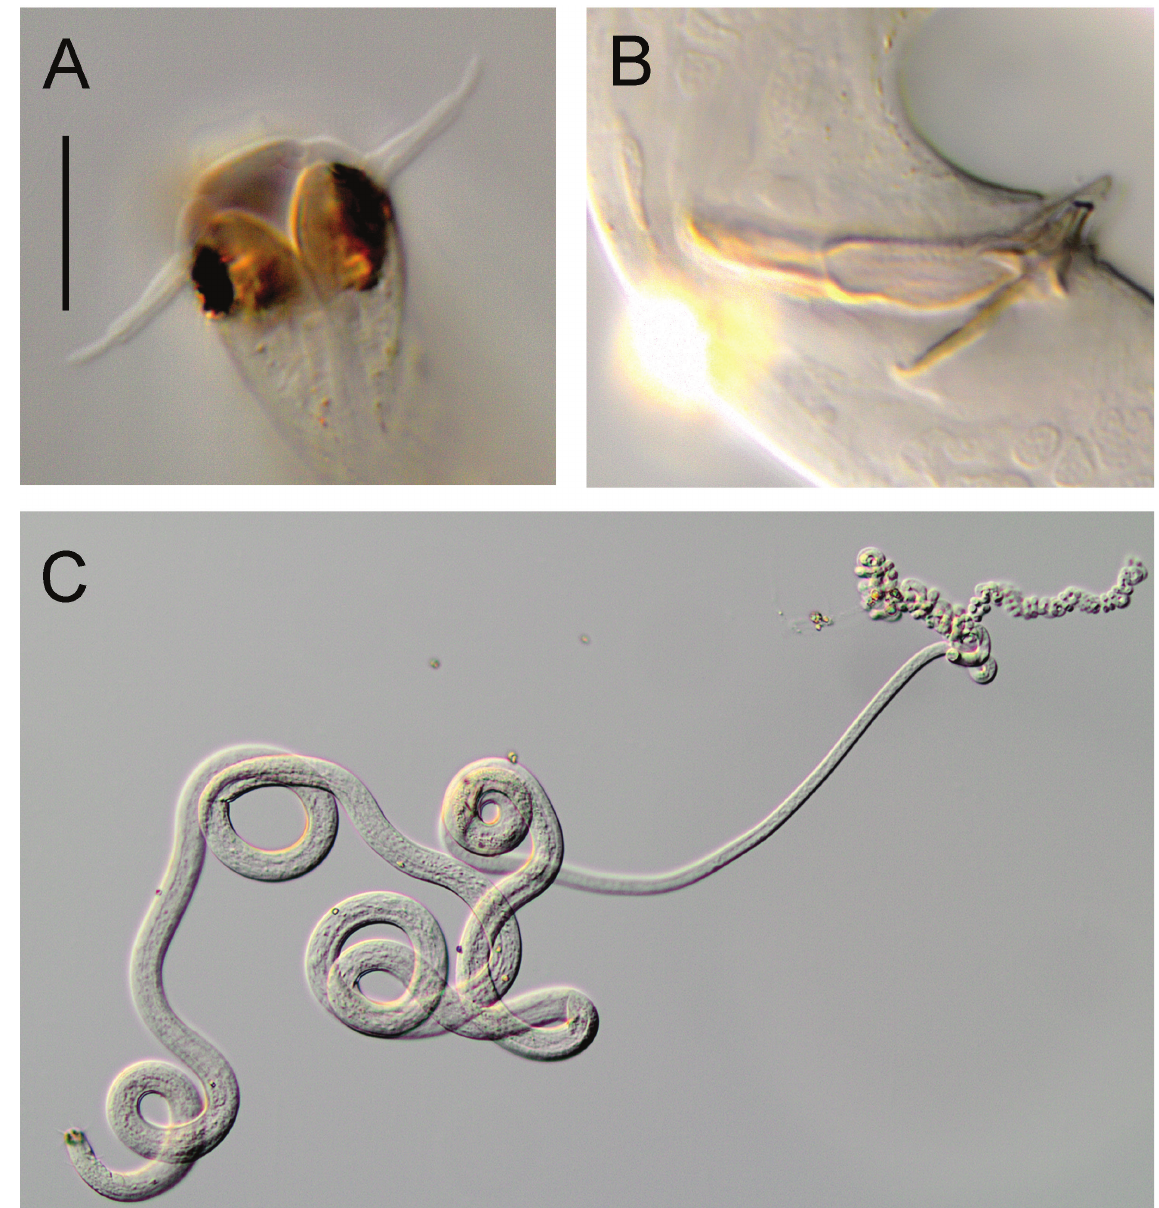
Fig. 2. Trefusia piperata sp. nov. Light micrographs. A . Head region of male, showing buccal cavity, cephalic setae, and clusters of dark granules at base of outer labial setae. B . Spicule and gubernaculum. C . entire male. Scale bar: A-B = 10 µ m; c = 100 µ